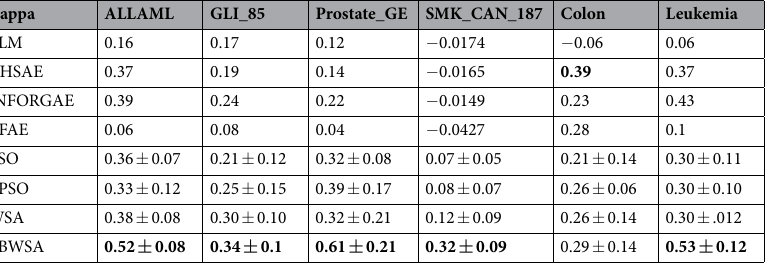
Table 3. Kappa statistics for all datasets with different methods (best results highlighted in bold).